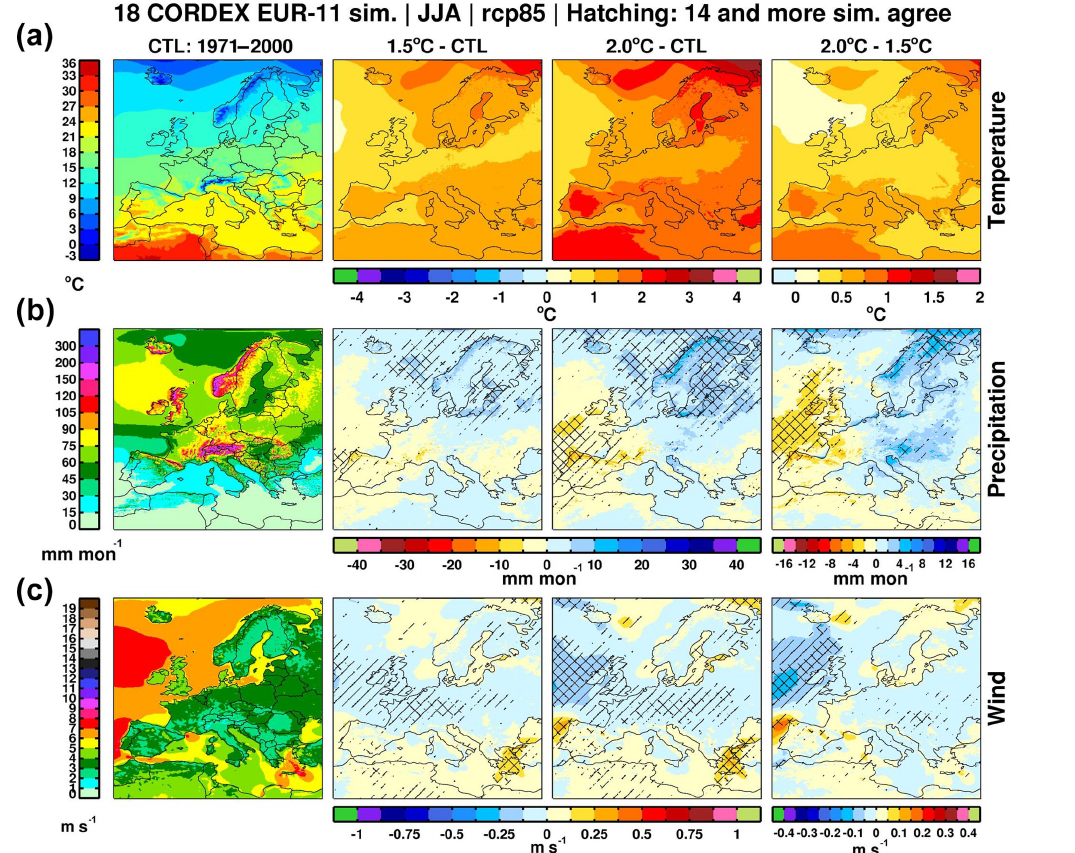
Figure 5. Ensemble mean summer (JJA) 2m temperature (a) , precipitation (b) and 10m wind speed (c) in the control period (left), its change at SWL1.5 (second column) and SWL2 (third column), and the difference between the change at SWL2 and SWL1.5 (rightmost column). Hatching in the climate change signal for precipitation and wind speed represents areas where at least 14 of the 18 ensemble members agree on the sign of change (for temperature this is always the case). Cross-hatching indicates that there is agreement on the sign of change and that the signal-to-noise ratio is larger than 1. Hatching in the rightmost plots indicates that changes at SWL2 are larger than those at SWL1.5 in at least 14 of the